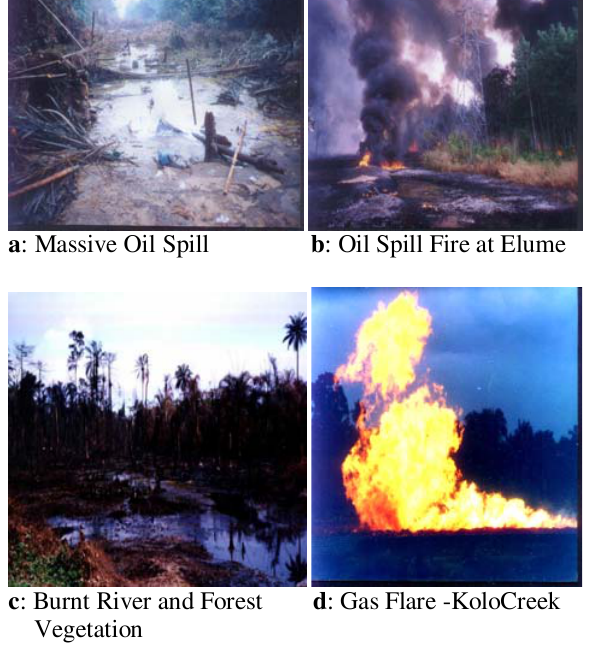
Figure 4: E xtent and nature of oil spills in selected areas of the region